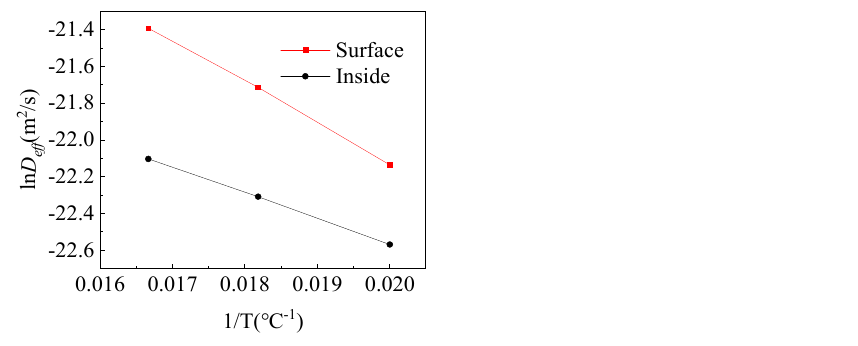
Figure 13. The effect of temperature on the effective moisture diffusivity on the surface and inside.